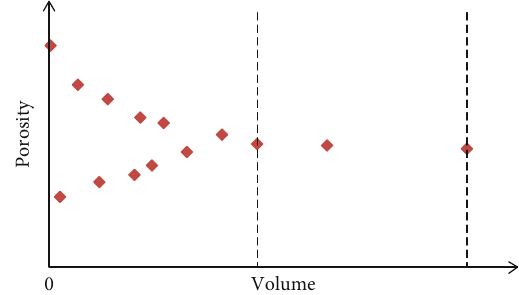
Figure 1: De fi nition of the representative elementary volume (REV): the point at which the petrophysical parameter (here porosity) turns constant is the minimum REV (the area between the two discontinues